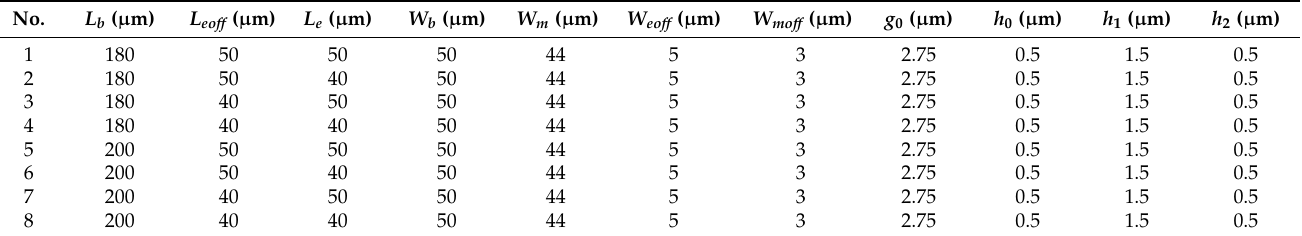
Table 2. Dimensions of test structures A and